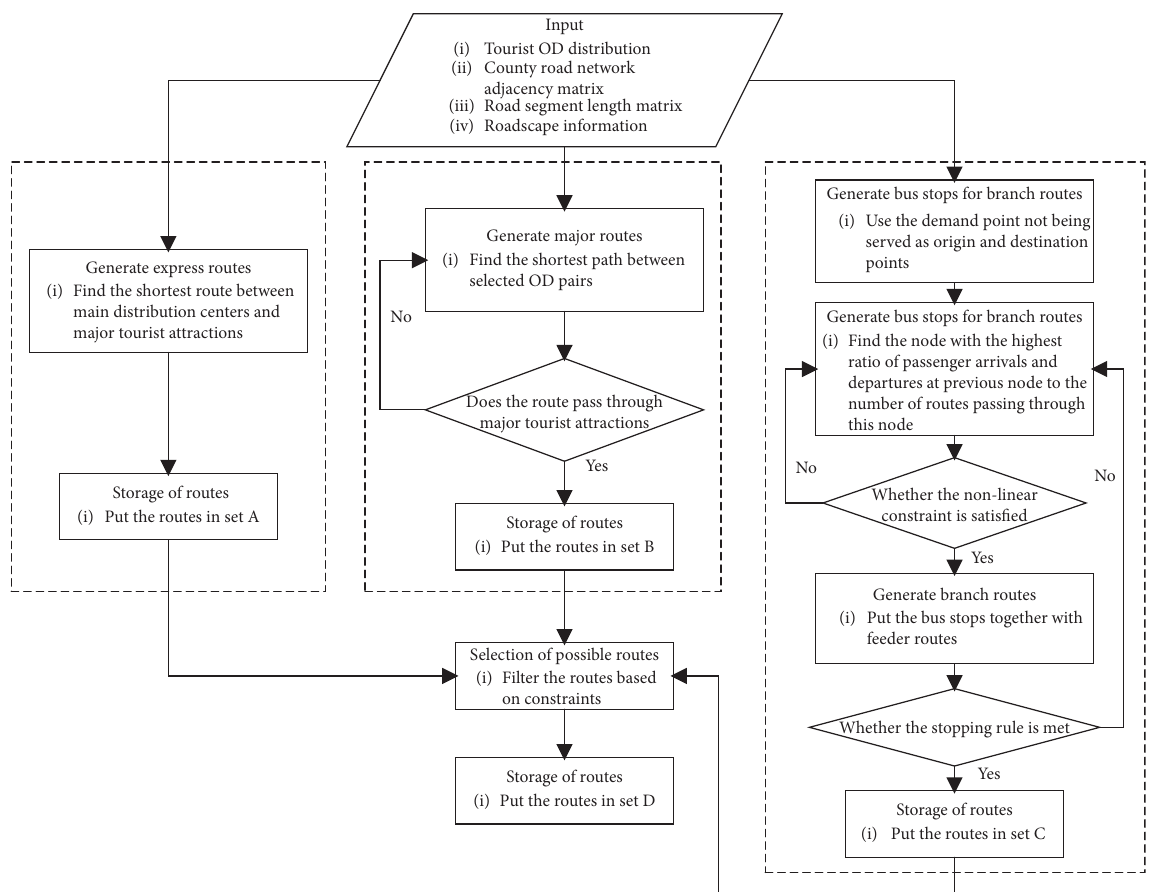
Figure 2: Flowchart of initial tourism bus route set